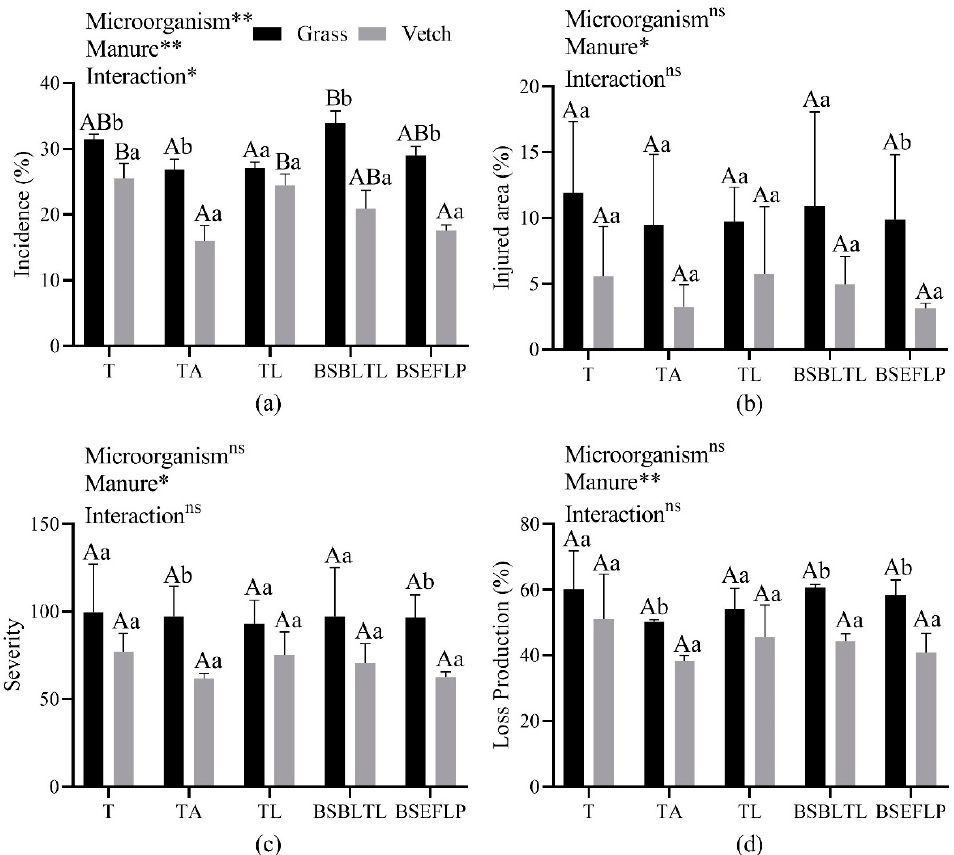
Figure 3. ( a ) Injured tuber incidence, ( b ) potato common scab-injured superficial area, ( c ) disease severity index, ( d ) and production loss (%) as a function of organic cover and biocontrol agents. ** means significantly in p < 0.01, * means significantly in p < 0.05, ns means no significant difference. T = control, TL = T. longibrachiatum , TA = T. asperellum , BSBLTL = B. subtilis + B. licheniformis + T. longibrachiatum , BSEFLP = B. subtilis + E. faecium + L. plantarum . Mean values followed by the same lowercase and uppercase letters did not differ significantly in cover crop and microorganisms, respectively, based on Tukey’s test ( p < 0.05); CV (%): ( a ) 9.73, ( b ) 35.44, ( c ) 11.58, ( d ) 17.2.